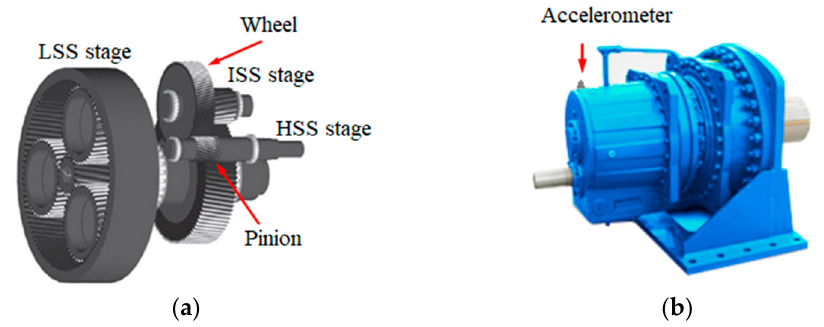
Figure 1. Schematic ( a ) and general ( b ) view of the WTG gearbox. The number of pinion gear teeth was 25 and, for the wheel, it equaled 94. The duration of the raw signal was 3.35 s (8192 samples). The vibration segments, which correspond to different stages of gear tooth failure, are shown in Figure 2. The speeds of the high-speed shaft (HSS) rotation were measured by means of a tachometer and for each stage were, respectively, 1451.55 rpm, 1442.85 rpm, and 1404.75 rpm. It can be seen from